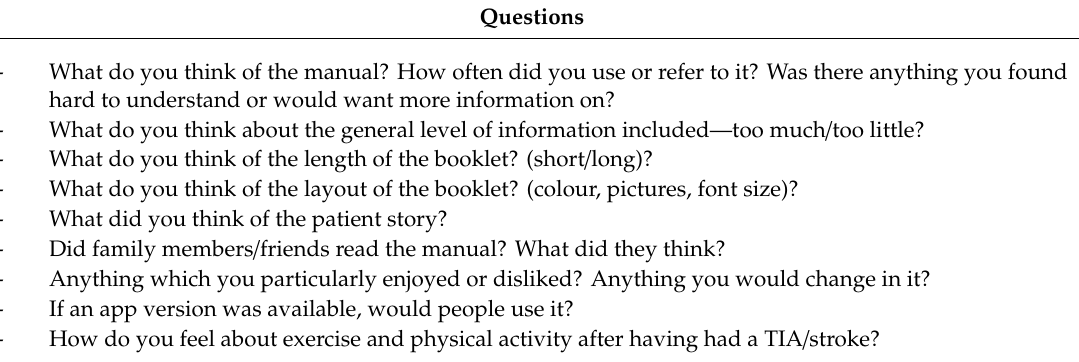
Table 2. Topic guides for interviews and focus group